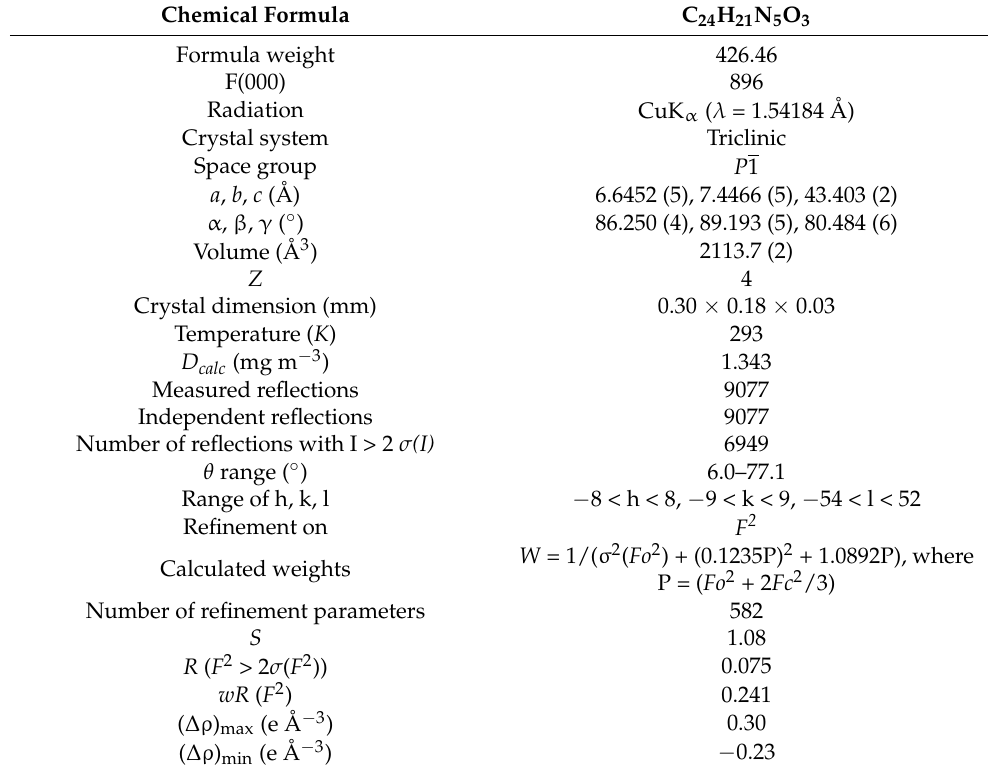
Table 10. Crystallographic data of 2